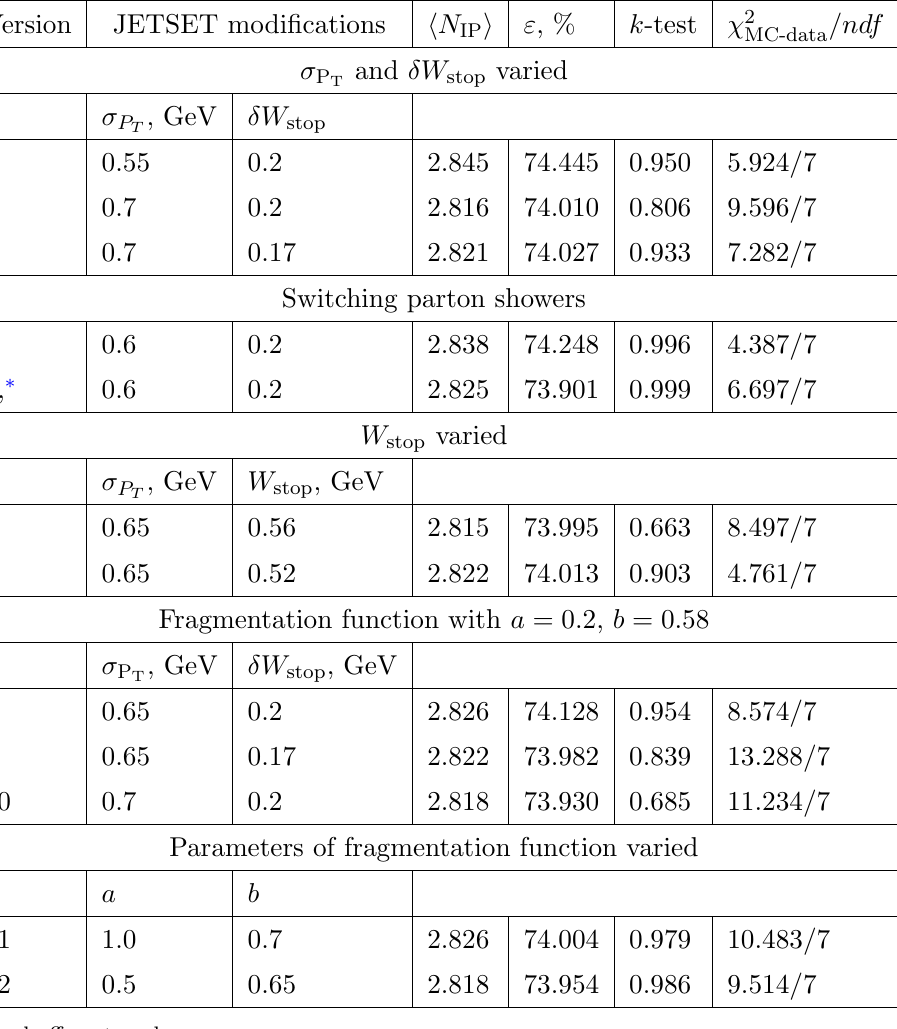
Table 4 . Comparison of di(cid:11)erent versions of MC simulation for J= decays. JETSET modi(cid:12)cation parameters are presented. For each simulated sample, the detection e(cid:14)ciency was calculated and results of Kolmogorov and (cid:31) 2 tests on the charged multiplicity distribution are shown as well as average